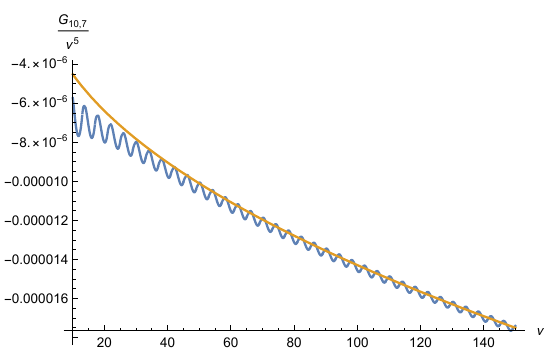
in the 2d Ising model. We plot 1 10 ; 7